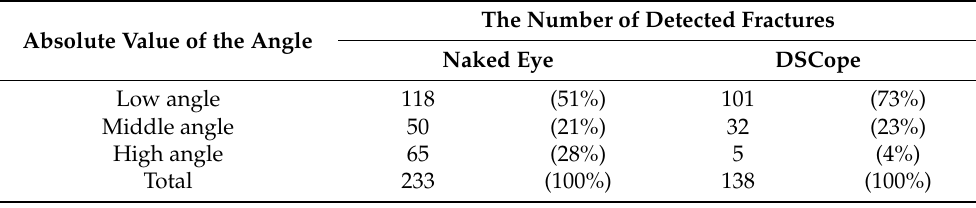
Table 1. Comparison between the number of fractures detected by the naked eye and DSCope. Absolute Value of the